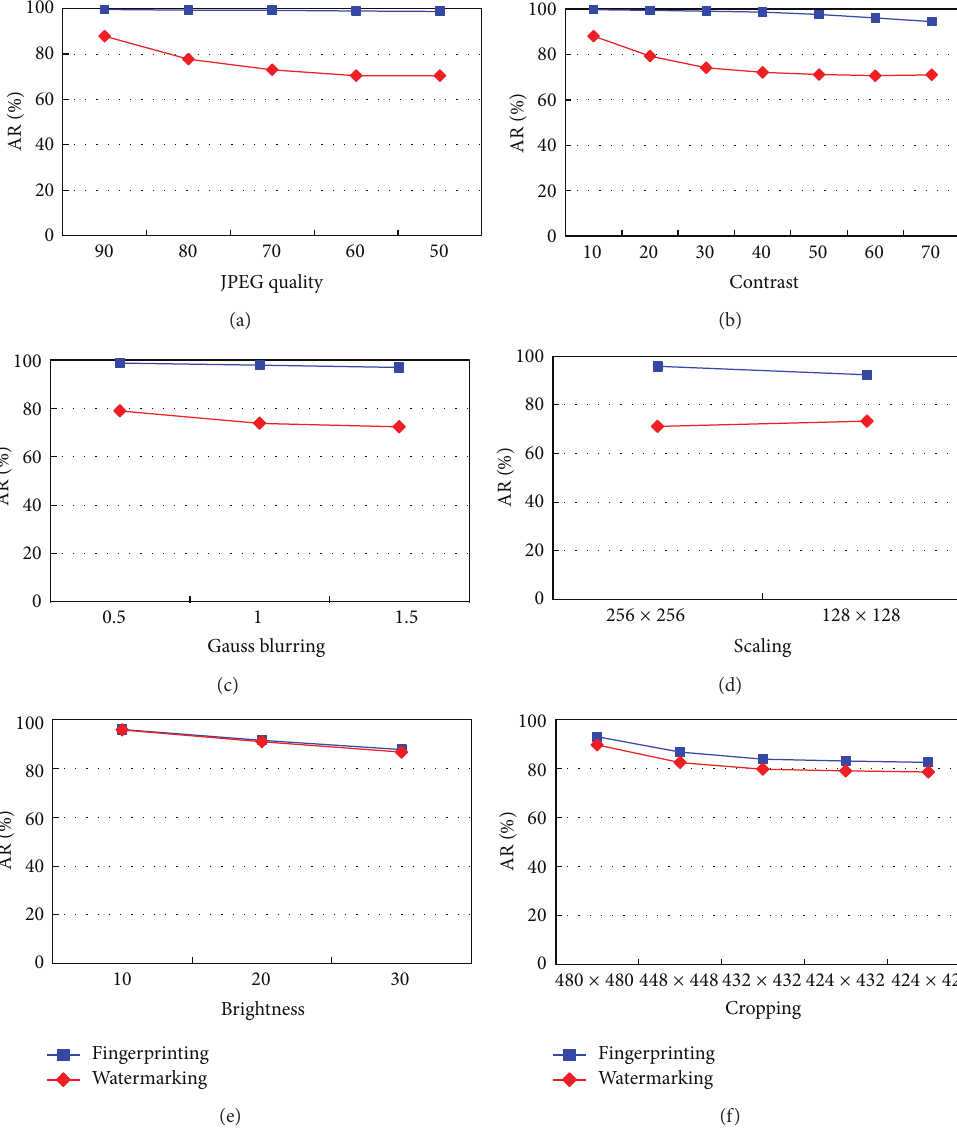
Figure 15: The average AR values of test images: (a) JPEG quality, (b) contrast, (c) Gauss blurring, (d) scaling, (e) brightness, and (f)